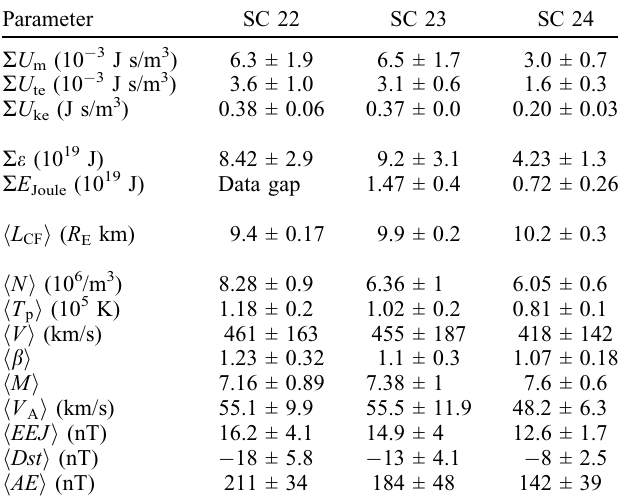
Table 5. Integrated energy densities and average of different parameters for SCs 22. 23, and 24 are summarized.